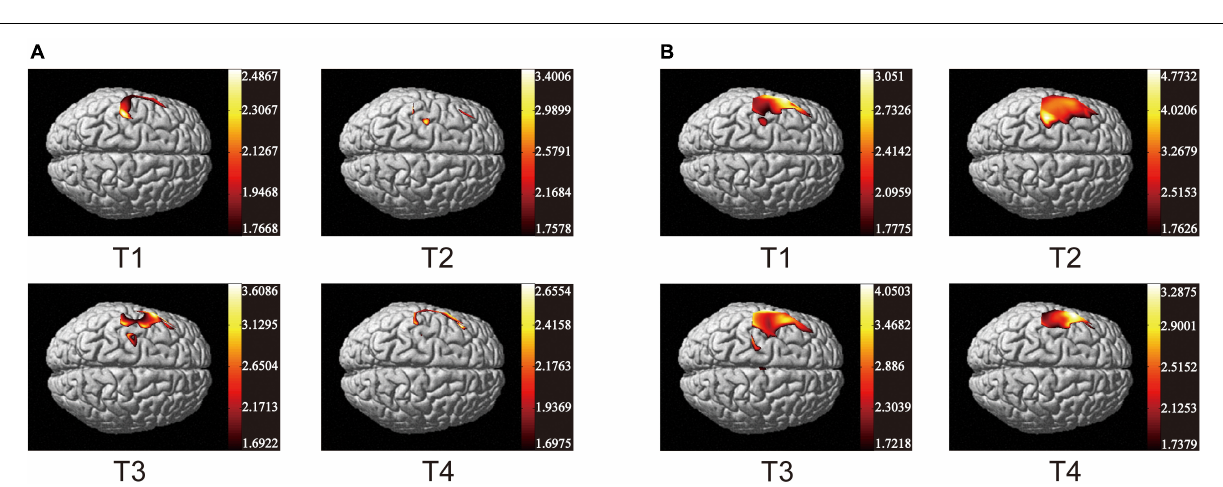
FIGURE 3 | Activation maps of cerebral cortex from trajectory 1 to trajectory 4. (A) Non-resistance movement; (B) resistance movement. The change from red to yellow indicates that the degree of activation is from low to high. The coordinates in the figure show the activation range of the cerebral cortex in each mode. The data are t values, t:statistical value of sample t -test [with a significance level of p < 0.05, Lipschitz-Killing curvature (LKC)-based expected Euler characteristics (EC) correction]. The data and maps are calculated and generated by